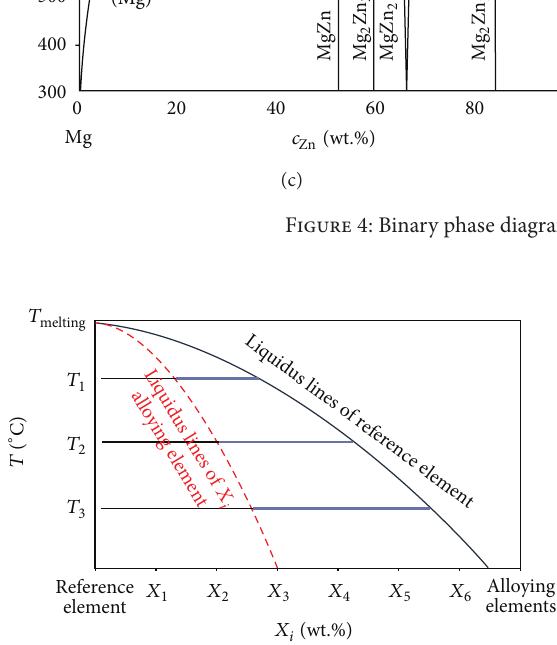
Figure 5: Superimposed liquidus lines of the reference element and 𝑋 𝑖 alloying elements in any binary